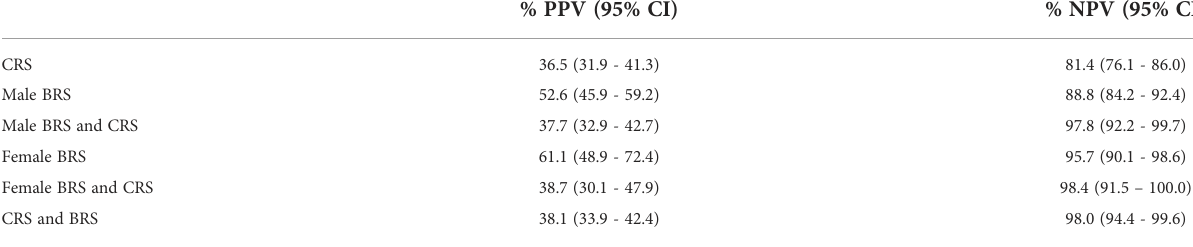
TABLE 3 Positive and negative predictive value by biomarker risk score (BRS) and clinical risk score (CRS) by